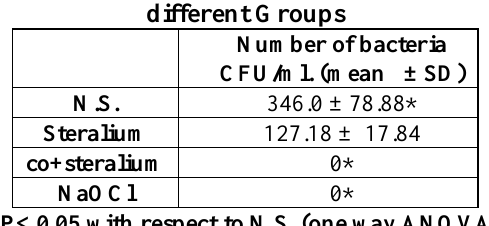
Table 3: Quantitative Analysis of Six-Week E. faecalis Biofilm Formed on Tooth Substrate